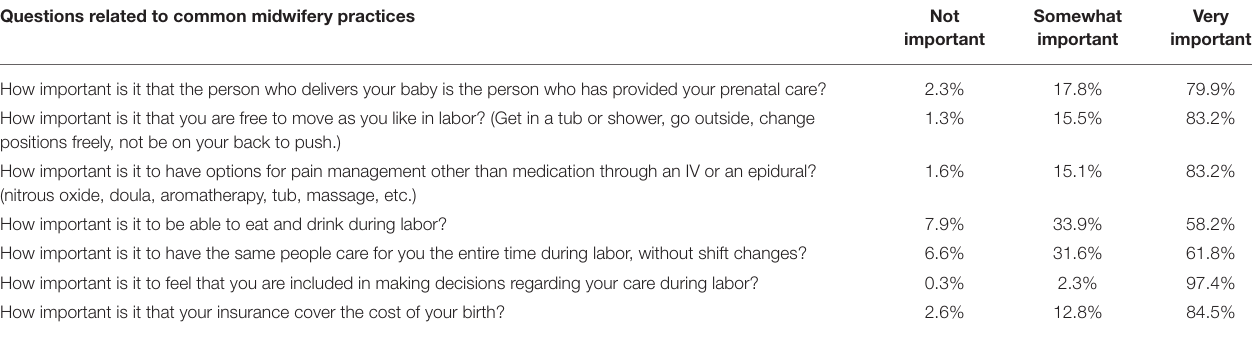
TABLE 1 | Importance of the midwifery model of care ( n =